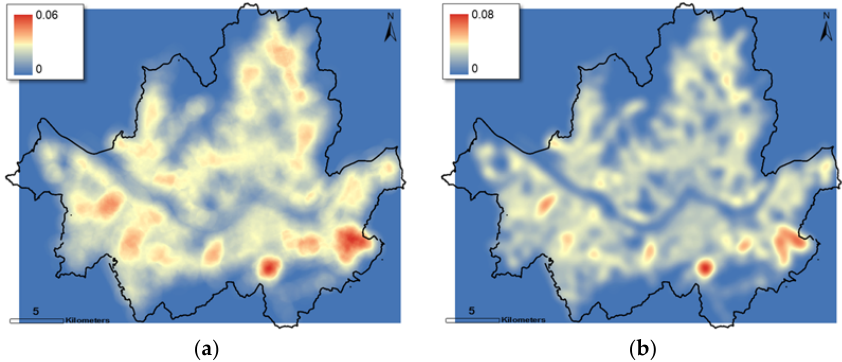
Figure 4. Geostatistical density of pipeline information based on ( a ) point density and ( b ) kernel density.